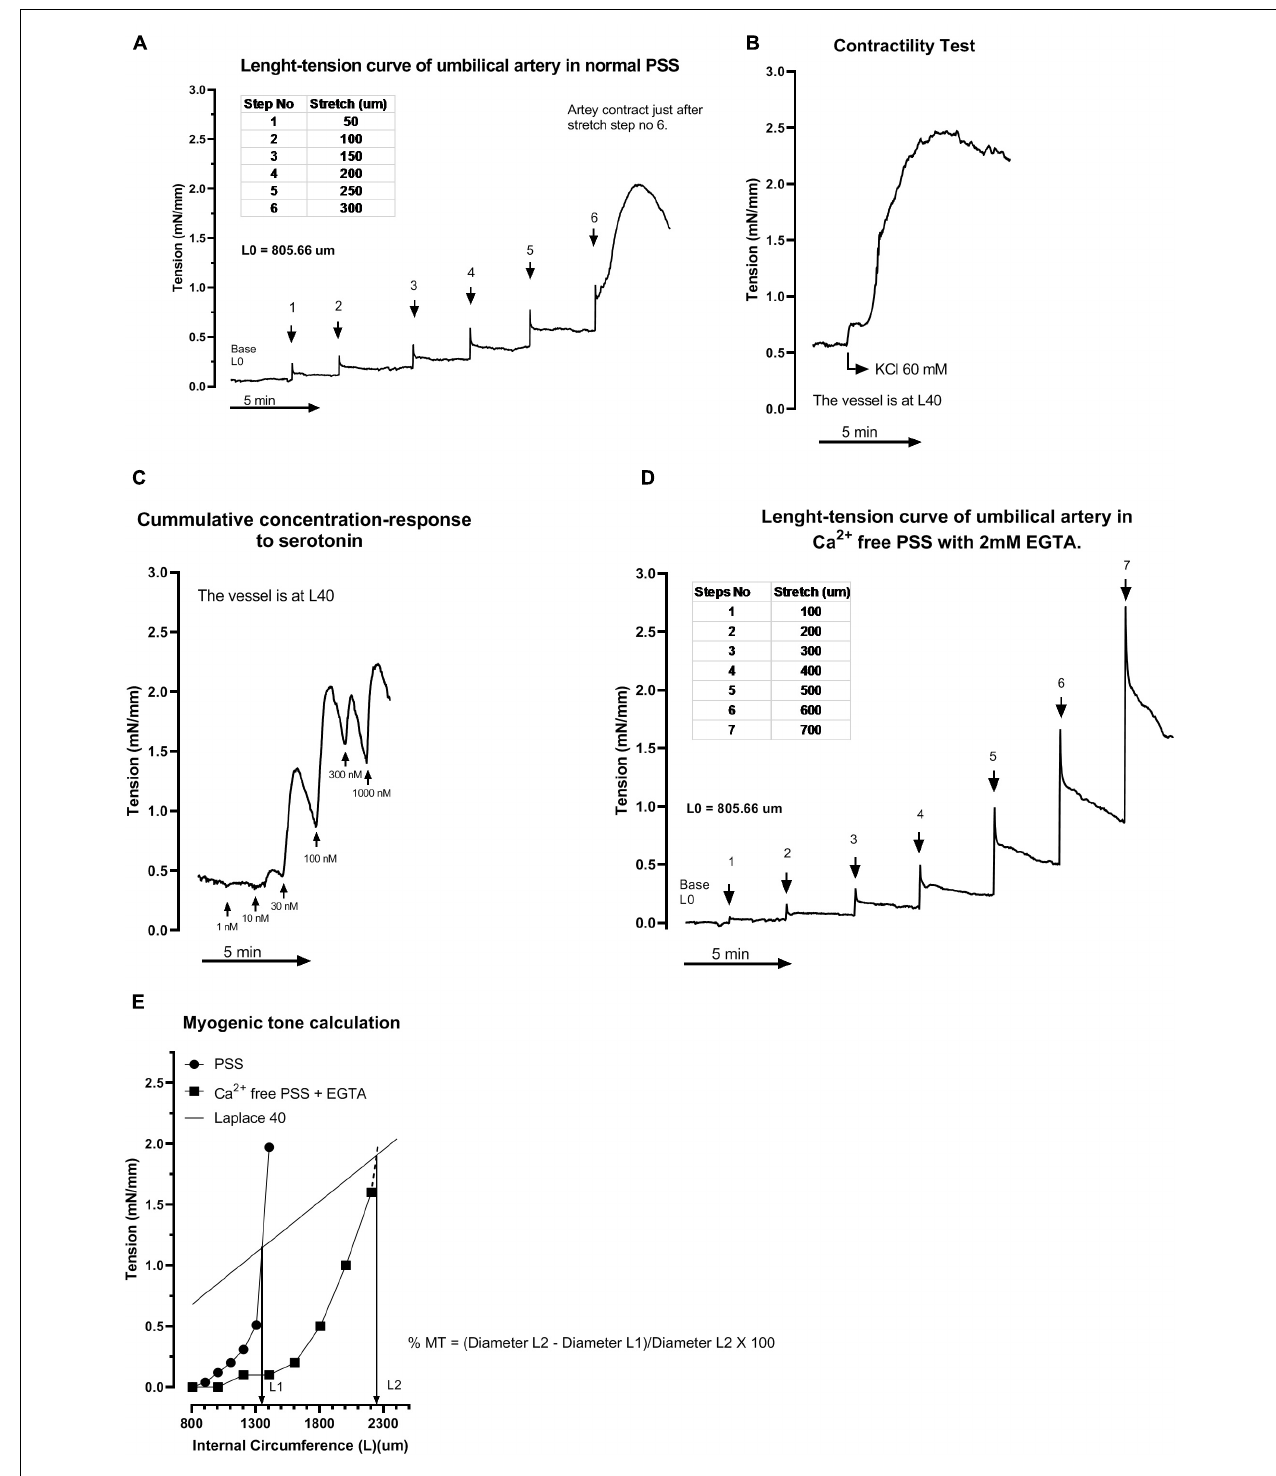
FIGURE 3 | Representative tracing of the experimental protocol in an umbilical artery (similar protocol for the vein). Vessels were set at L0, a first length-tension (L-T) curve is recorded to normalize the vessels at L40 or L20 (A) . Then, contractility of the preparation is tested with a 60 mM potassium chloride challenge (B) . PSS is replaced by fresh PSS and vessels are allowed to rest 60 min before cumulative concentration-response curve to U46619 or Serotonin (C) . After washing the contractile agent response with fresh PSS, Ca 2 + free PSS (containing 2 mM EGTA) is added. The vessels are returned to L0, second L-T curve is measured with stretch steps of 100 µ m (D) . L40 or L20 are recorded and diameter in free calcium PSS calculated and recorded. Myogenic tone is calculated using this formula: % MT for artery = (Diameter L40 in Ca 2 + free PSS – Diameter L40 in PSS)/Diameter L40 Ca 2 + free PSS × 100 (E) .